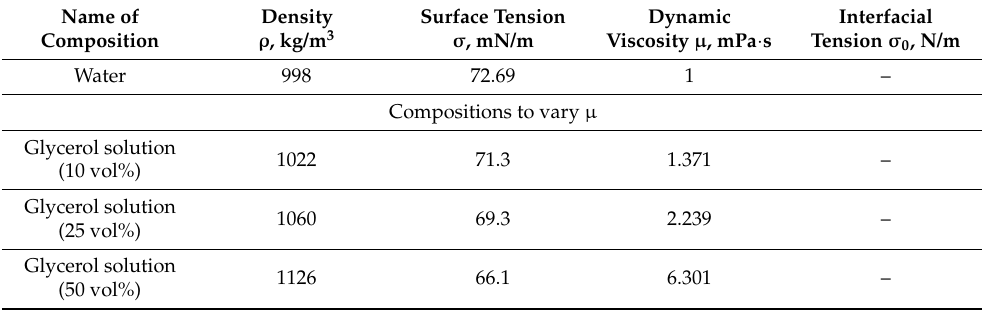
Table 1. Properties of liquids under